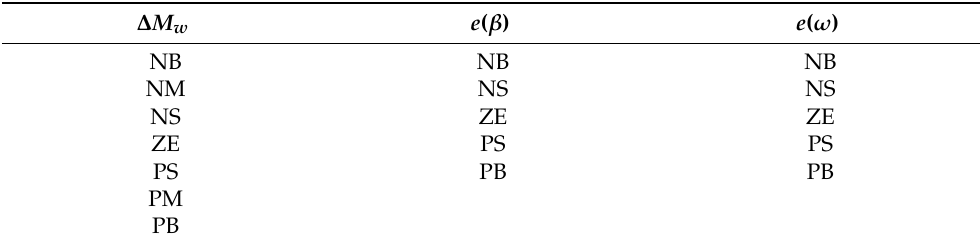
Table 8. Fuzzy set of input and output.